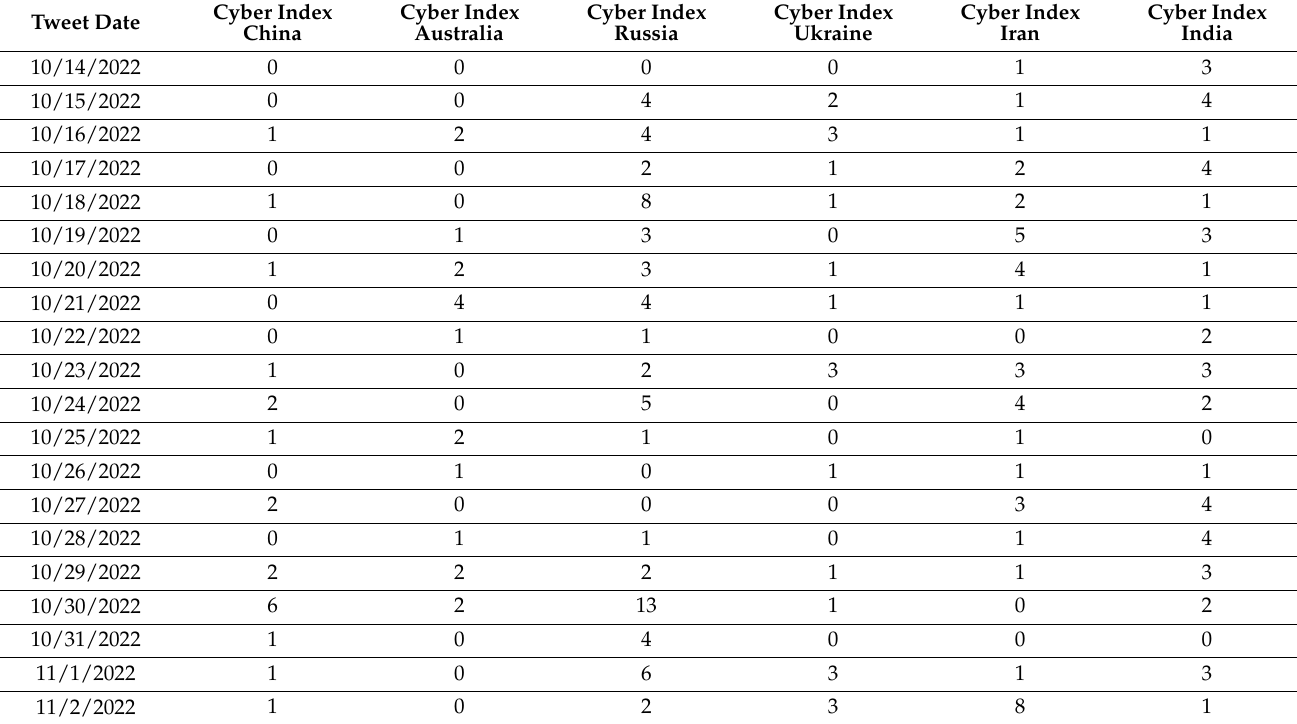
Table 7. Cyber index generated for six different